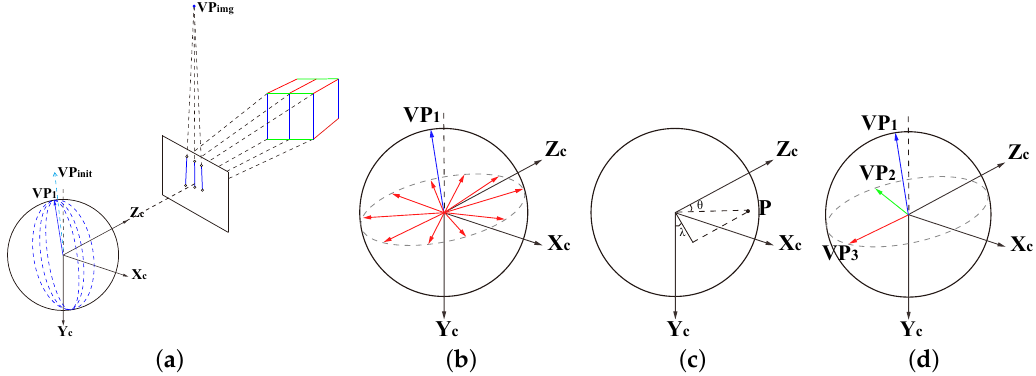
Figure 2. These figures show the extraction process of three orthogonal VPs (structural feature). Figure ( a ) shows the vertical direction VP init obtained after initialization is projected onto the image to obtain VP img , and the line segments are classified. The line segments belonging to the vertical direction are recomputed to obtain the vanishing point VP 1 in the vertical direction of this frame. Figure ( b ) shows VP 2 and VP 3 hypotheses generated by uniform sampling on the circle where the normal plane of VP 1 intersects the equivalent sphere. Figure ( c ) shows the VP hypotheses generate by all line segment pairs projected onto the polar grid. Figure ( d ) shows all the VP 2 and VP 3 hypotheses mapped into the polar grid, and the hypothesis corresponding to the maximum weight is the final global optimal VPs.